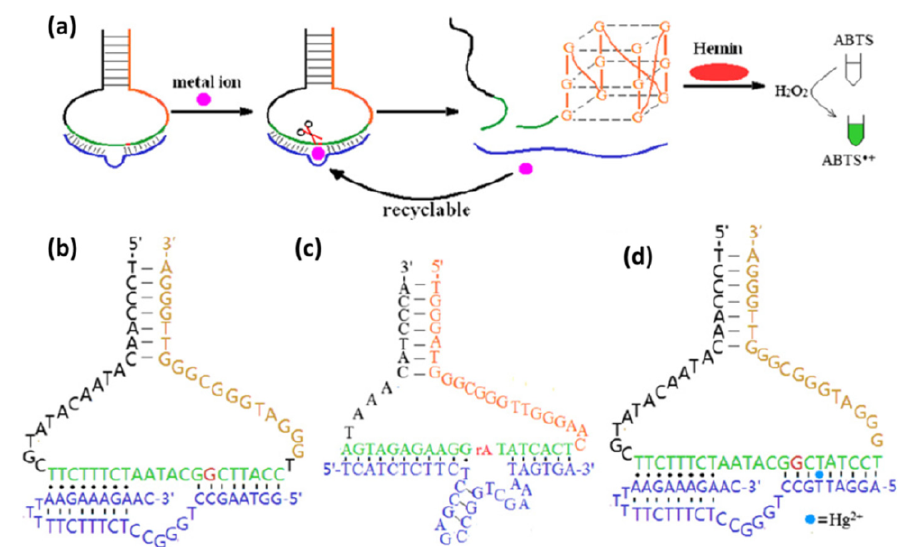
Figure 10. ( a ) The scheme of DNA biosensor for detecting metal ion including Hg 2+ based on the Cu 2+ -specific DNAzyme and G-quadruplex DNAzymes. ( b ) The Cu 2+ -specific DNAzyme, ( c ) Pb 2+ - specific DNAzyme, and ( d ) the modified Cu 2+ -specific DNAzyme for Hg 2+ biosensor. Reprinted with permission from [85]. Copyright 2012